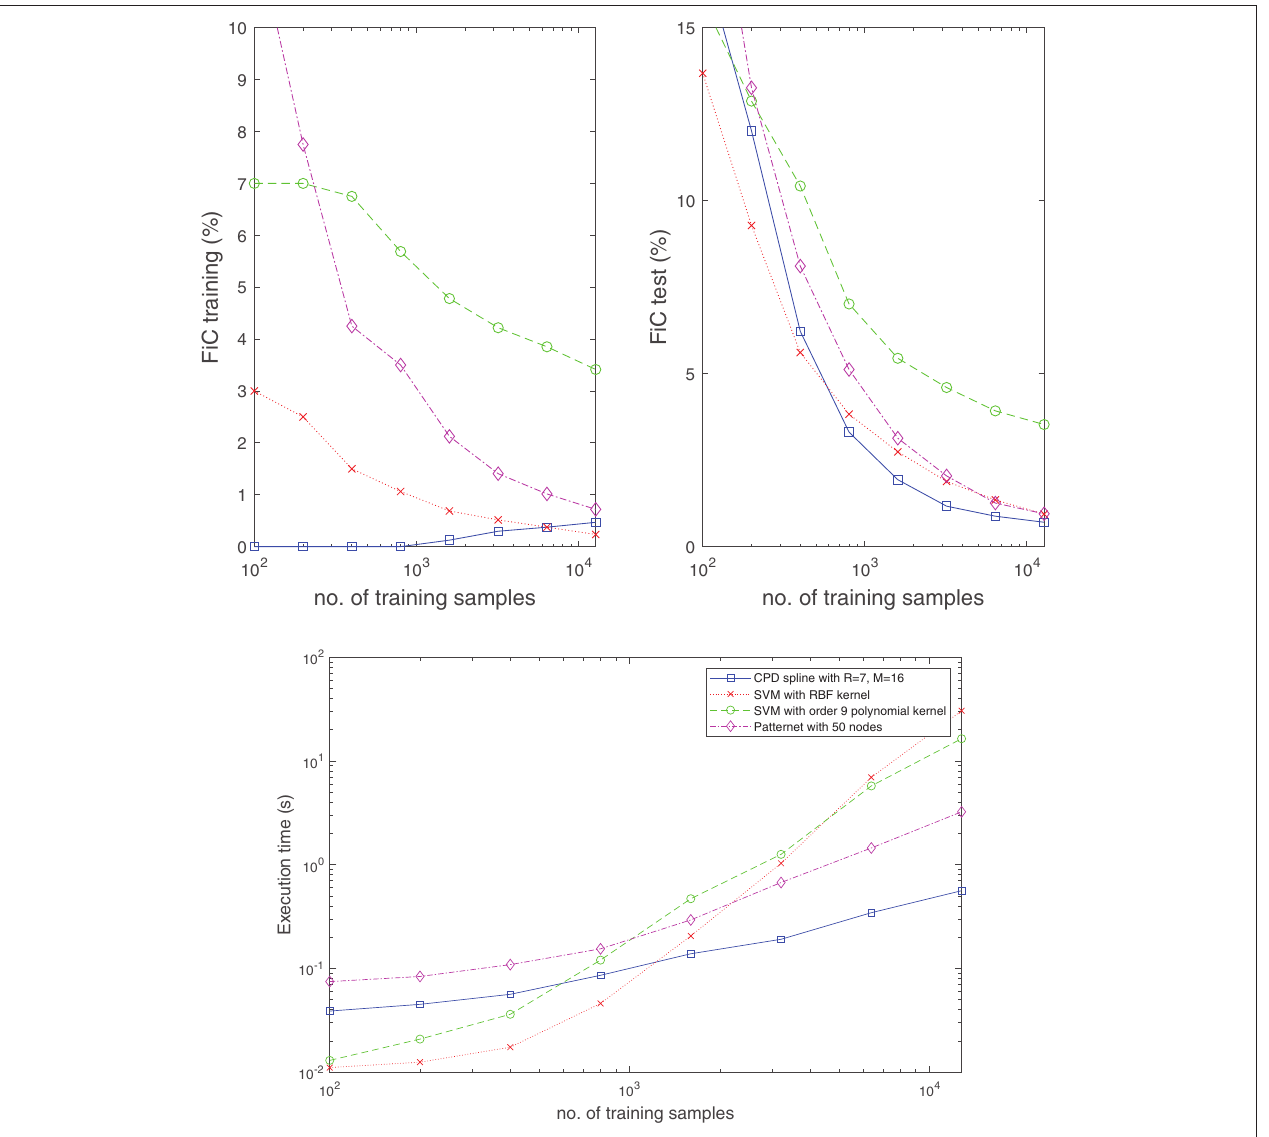
FIGURE 12 | The classifier (Equation 21) is competitive with well-established techniques in terms of classification accuracy and computation time. Shown is the median result obtained from 50 randomly generated training and test datasets for the classification problem in Figure 11 . Specifically, for the SVMs and NN, the built-in Matlab routines fitcsvm and patternnet were used to develop the results. Whereas the top two plots display the obtained fraction incorrect (FiC) for the training and test dataset, respectively, the bottom plot shows the required CPU time to complete the training. The test dataset size always equals 5000 samples.